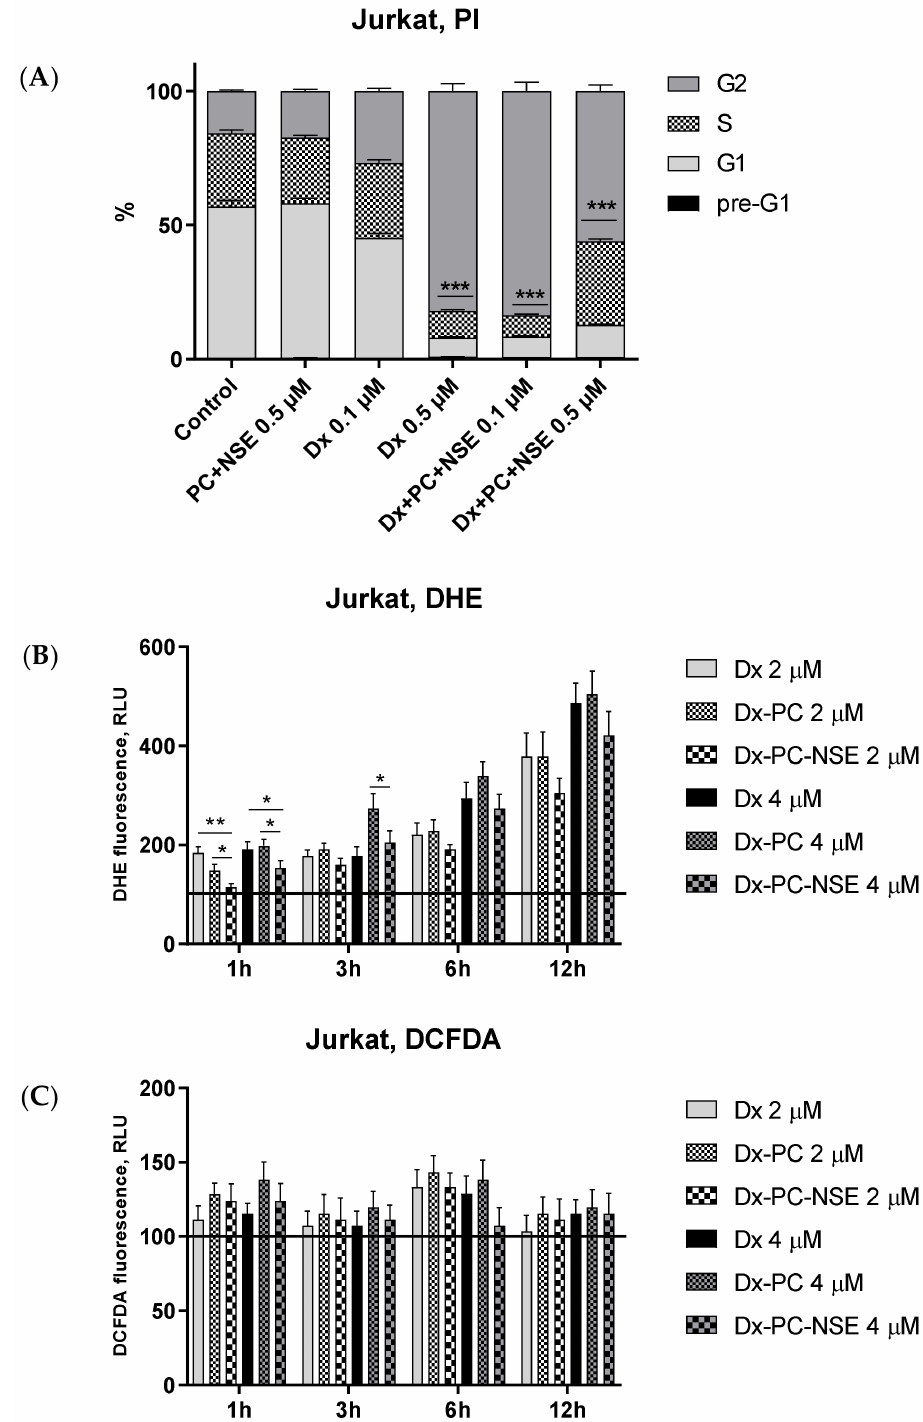
Figure 8. Flow cytometry analysis of impact of co-immobilization of Dx and NSE on PC on cell cycle distribution and ROS induction in Jurkat cells. ( A ) Changes in cell cycle distribution, PI staining, 24 h incubation. ( B ) Time-dependent studies of O 2 − production, DHE assay, 1,3,6,12 h incubation. ( C ) Time-dependent studies of H 2 O 2 production, DCFDA assay, 1,3,6,12 h incubation. Data are given relative to the untreated control samples (baseline) and represent the mean ± SD of three independent experiments. Significance to other treatments was calculated by Student’s unpaired t -test (* p < 0.05; ** p < 0.01; *** p <